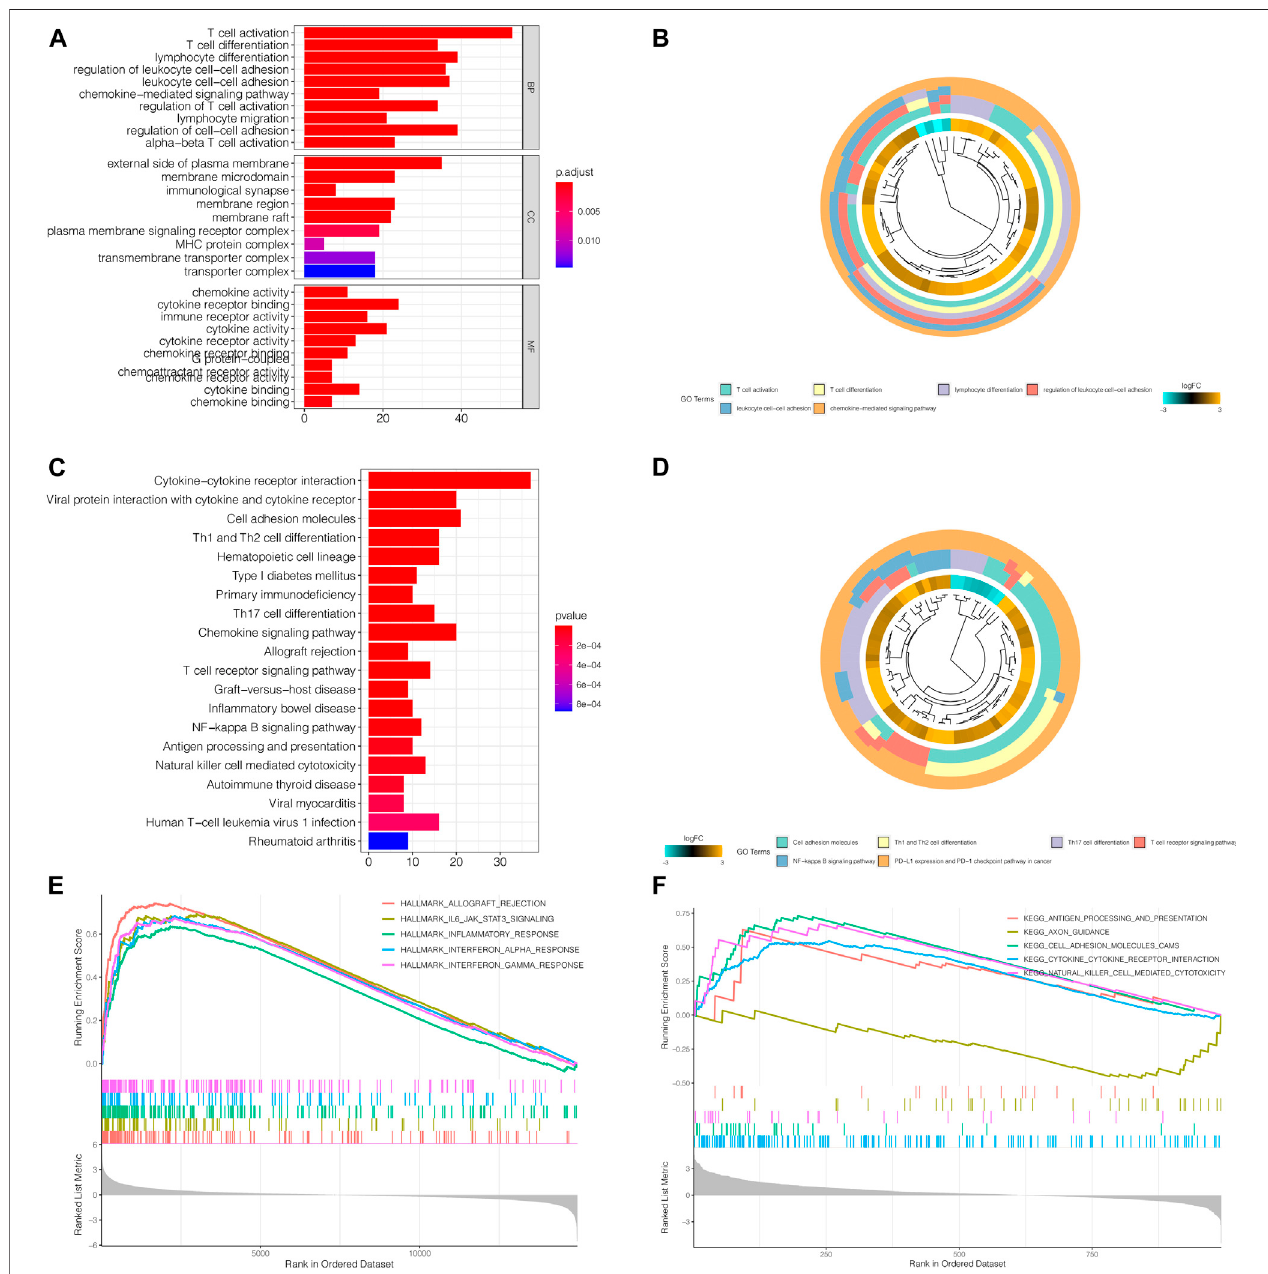
FIGURE 6 | GO and KEGG Enrichment Analysis revealed that the differential genes between high risk and low risk groups were strongly correlated with immune response. (A,B) GO Enrichment analysis revealed that, biological processes like T cell activation and differentiation, lymphocyte differentiation and leukocyte cell-cell adhesion; molecular functions such as chemokine activity, cytokine activity, immune receptor activity, as well as cytokine receptor activity were enriched in differential genesbetweenthehigh-riskgroupand thelow-riskgroup. Theenriched genesweremainlyconcentratedintheexternal sideoftheplasmamembrane, whichwas in line with our fi ndings that the differential genes were correlated immune response. (C,D) KEGG analysis revealed a more speci fi c picture of which pathways were enriched between the two groups. Not only was Th1 and Th2 cell differentiation related to the risk model, but PD-1 and PD-L1 activity was also concerned. However, further studied are still needed to validate the relationship between the relationship with our model and immune response. (E) GSEA showed that immune-related functionalgenesetsweremainlyenrichedinthehigh-riskgroup,includingallograftrejection,IL6-JAK-STAT3signalingpathway,in fl ammatoryresponse,interferon-alpha response, interferon-gamma response. (F) 2,483 immune-related genes were downloaded from IMMPORT database. Through GSEA analysis, we found that these immune-related genes are mainly enriched in antigen processing and presentation, cell adhesion molecules, cytokine receptor interactions, and ccytotoxicity mediated by natural killer cells in the high-risk group. Axon guidance was the main enrichment pathway in the low-risk group.